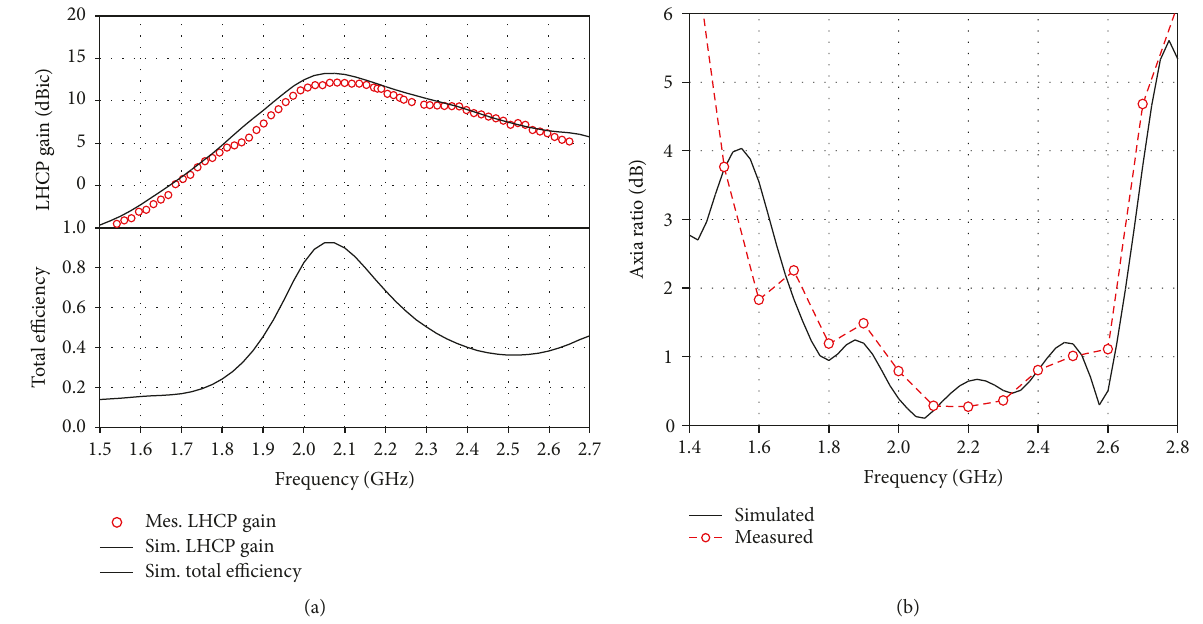
Figure 12: (a, b) Simulated and measured axial ratio and realized gain of the array. Table 1: Measured performance comparison of the proposed design and the previous 2 × 2 CP arrays.